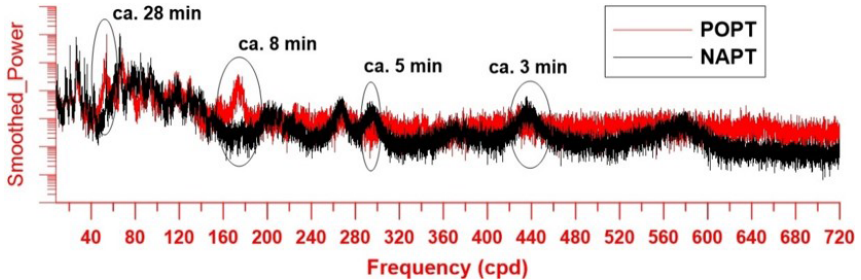
Figure 7. Spectrum of the smoothed power for POPT and NAPT tide gauges in the frequency range 40–720 cpd.